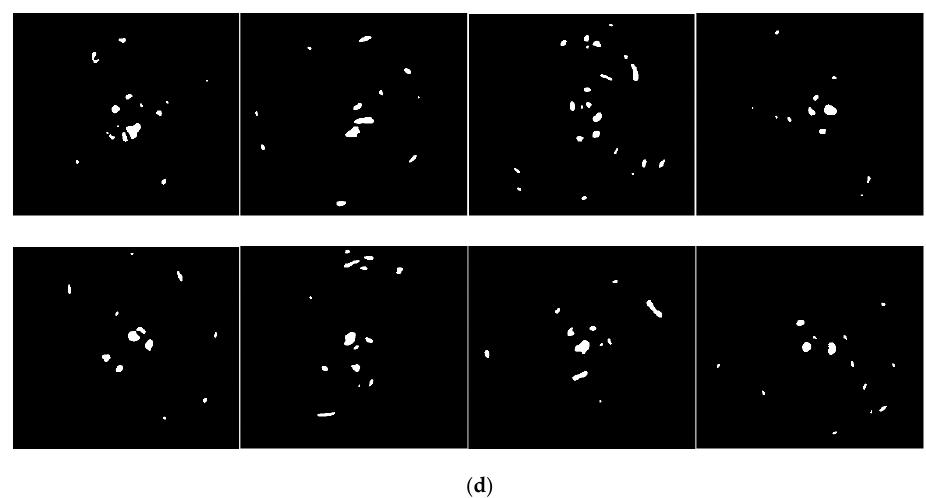
Figure 15. Vortex shape on four special sections at eight moments. ( a ) Vortex shape on S3 at eight moments; ( b ) Vortex shape on S9 at eight moments; ( c ) Vortex shape on S19 at eight moments; ( d ) Vortex shape on S29 at eight moments. Figure 16 is the comparison of D a at eight moments on four special sections. The results show that D a in different zones has a certain size law, but it also changes with time. Figure 16a shows the D a of vortex on four special sections at eight continuous moments. The D a of S3 is the largest and the D a of S29 is the smallest. From the Figure 16b listed, it can be seen that the D a of S9 representing the spiral vortex rope zone changes greatly over time com- pared with the other three zones. The spiral vortex rope zone is vulnerable to the impact of axial flow, resulting in the instability of the spiral vortex rope zone, the boundary between the spiral vortex rope zone and the broken vortex rope zone is not obvious, resulting in a large change in D a . Figure 16c shows that the D a of four zones decreases gradually as the vortex rope spiral downstream. The vortex rope upstream of S9 maintains its own morphol- ogy and the vortex rope downstream of S9 breaks up. The vortex rope at the S9 section is at the position of the strongest oscillation and may maintain its own morphology at different moments or may have broken up, resulting in a large range of variation in the fractal di- mension of the S9 section at different moments. By judging the pulsation amplitude of the fractal dimension, we can determine where the vortex rope starts to break up. The fractal dimensions are relatively stable in other sections and do not fluctuate much.